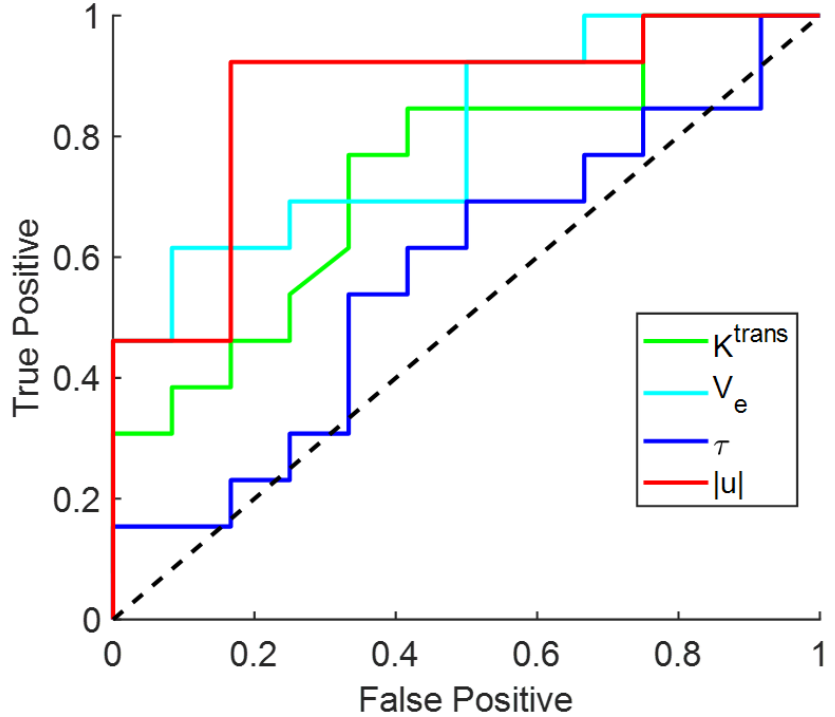
Figure 5. Receiver operating characteristic curve (ROC) for QTM | u | , K trans , V e , τ in differentiating low-risk (lung shunting fraction ≤ 10% ) and high-risk (lung shunting fraction > 10% ) subjects.